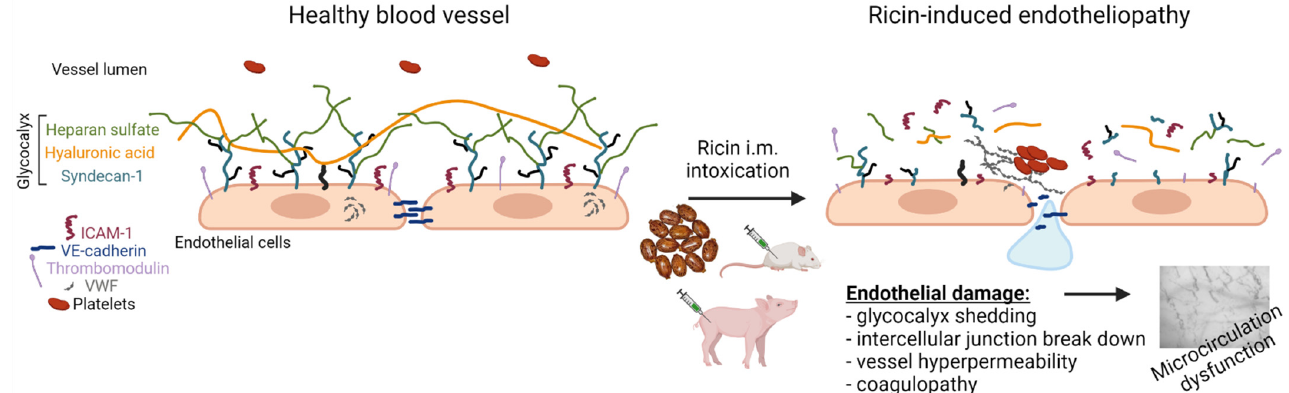
Figure 7. Schematic representation of ricin-induced vascular damage following i.m. exposure of mice and swine. Following ricin intoxication, the vascular endothelium underwent pathophysiological changes, such as degradation of various components of the glycocalyx (syndecan-1, HS and HA), the release of thrombomodulin and ICAM-1, exposure of VWF to the bloodstream and breakdown of VE-cadherin between adjacent endothelial cells. As a consequence of these events, widespread hemorrhages, coagulopathy, vascular hyperpermeability and eventually microvasculature malfunction were detected. Created with BioRender.com.